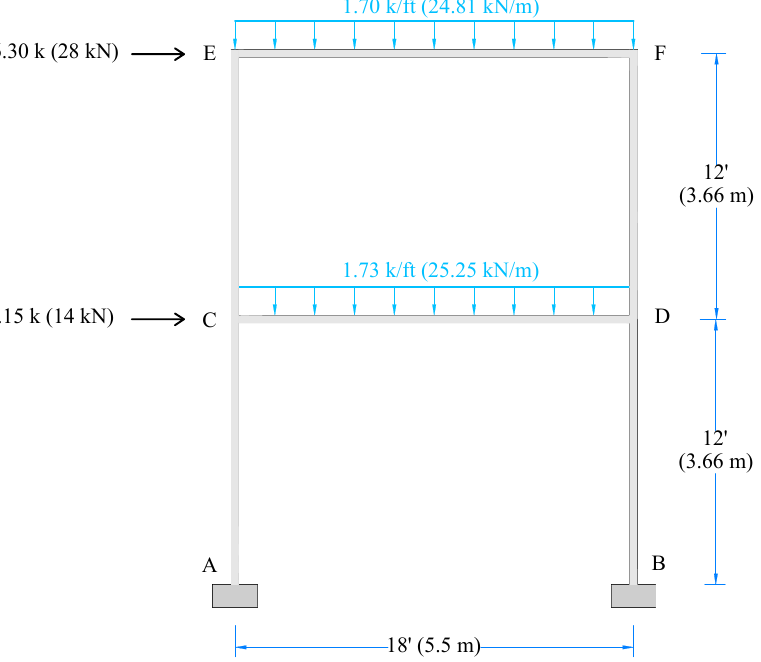
Figure 1. Selected moment-resisting reinforced concrete frame. Table 1. Preliminary chosen sizes of beams and columns and basic material properties.